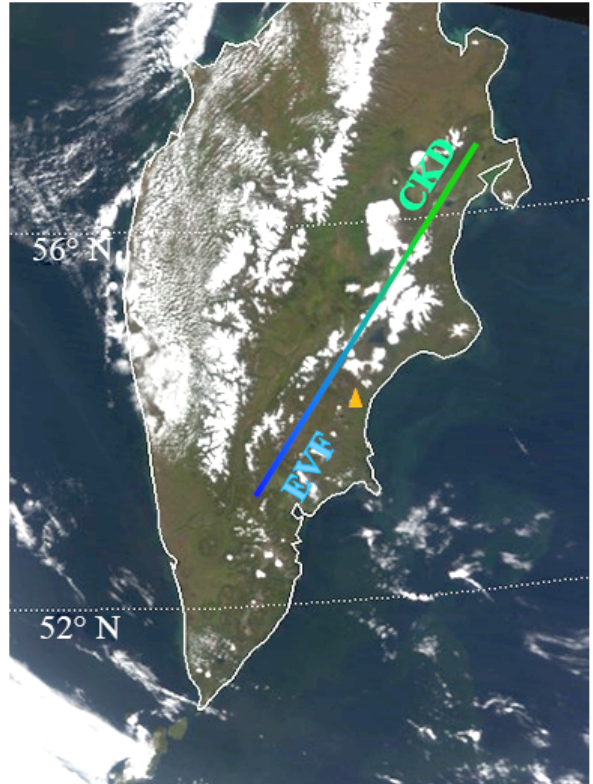
Figure 1. MODIS image of the Kamchatka Peninsula (Russia) on 22 September 2016. The orange triangle denotes the location of Karymsky volcano. The dominant geological features dividing the Kamchatka Peninsula, the Central Kamchatka Depression (CKD) and Eastern Volcanic Front (EVF) are also